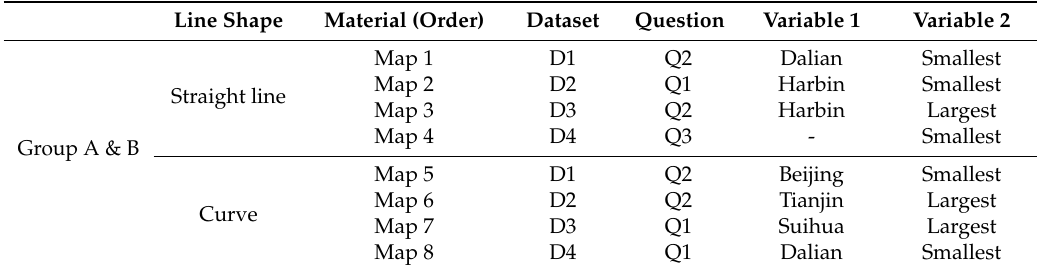
Figure 2. Group setting and material quantities in the experiment. SL = straight line; CV = curve; LT = line thickness; and CG = color gradient; M is the number of material flow maps; N is the number of participants. Table 1. Map order and question setting for materials in both